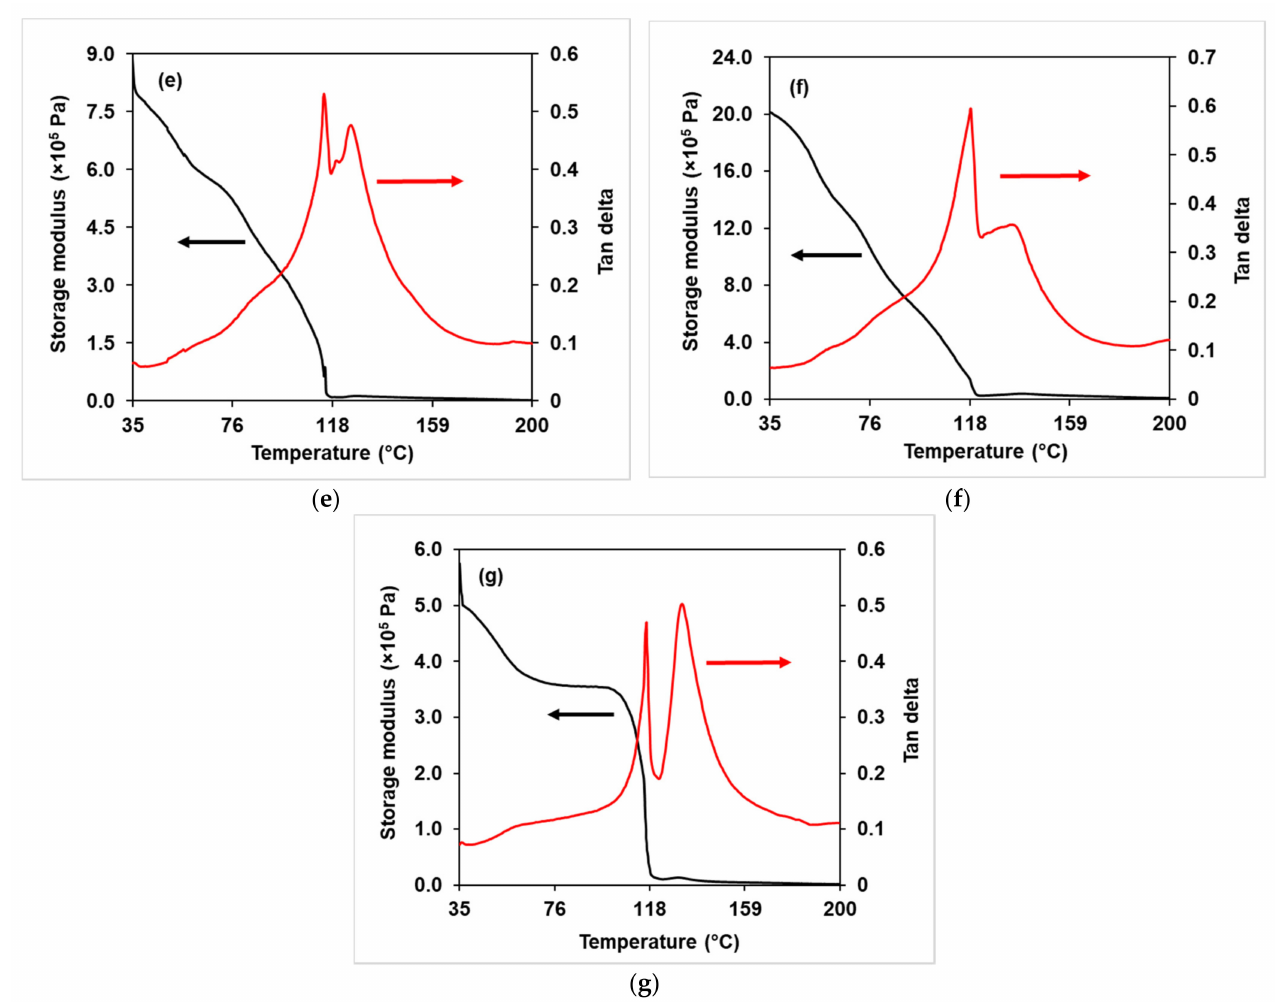
Figure 10. Tan δ and storage modulus of the ( a ) NMPC/PVA-SiO 2 (0.5 wt.%), ( b ) NMPC/PVA-SiO 2 (1 wt.%), ( c ) NMPC/PVA-SiO 2 (2 wt.%), ( d ) NMPC/PVA-SiO 2 (4 wt.%), ( e ) NMPC/PVA-SiO 2 (6 wt.%), ( f ) NMPC/PVA-SiO 2 (8 wt.%), and ( g ) NMPC/PVA-SiO 2 (10 wt.%) composite